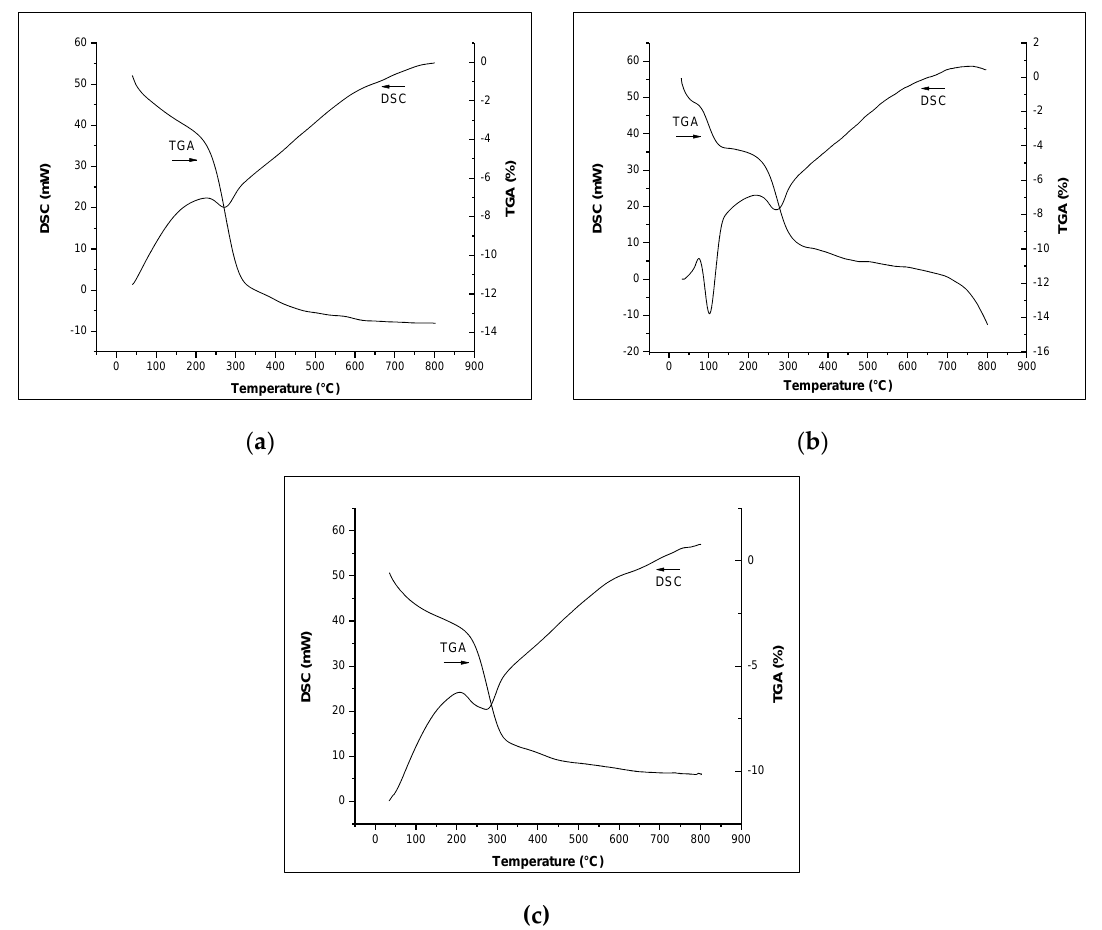
Figure 5. TGA/DSC patterns of ( a ) Limonite ore, ( b ) ore + Na 2 CO 3 and ( c ) ore + Na 2 SO 4 alkali roasting.